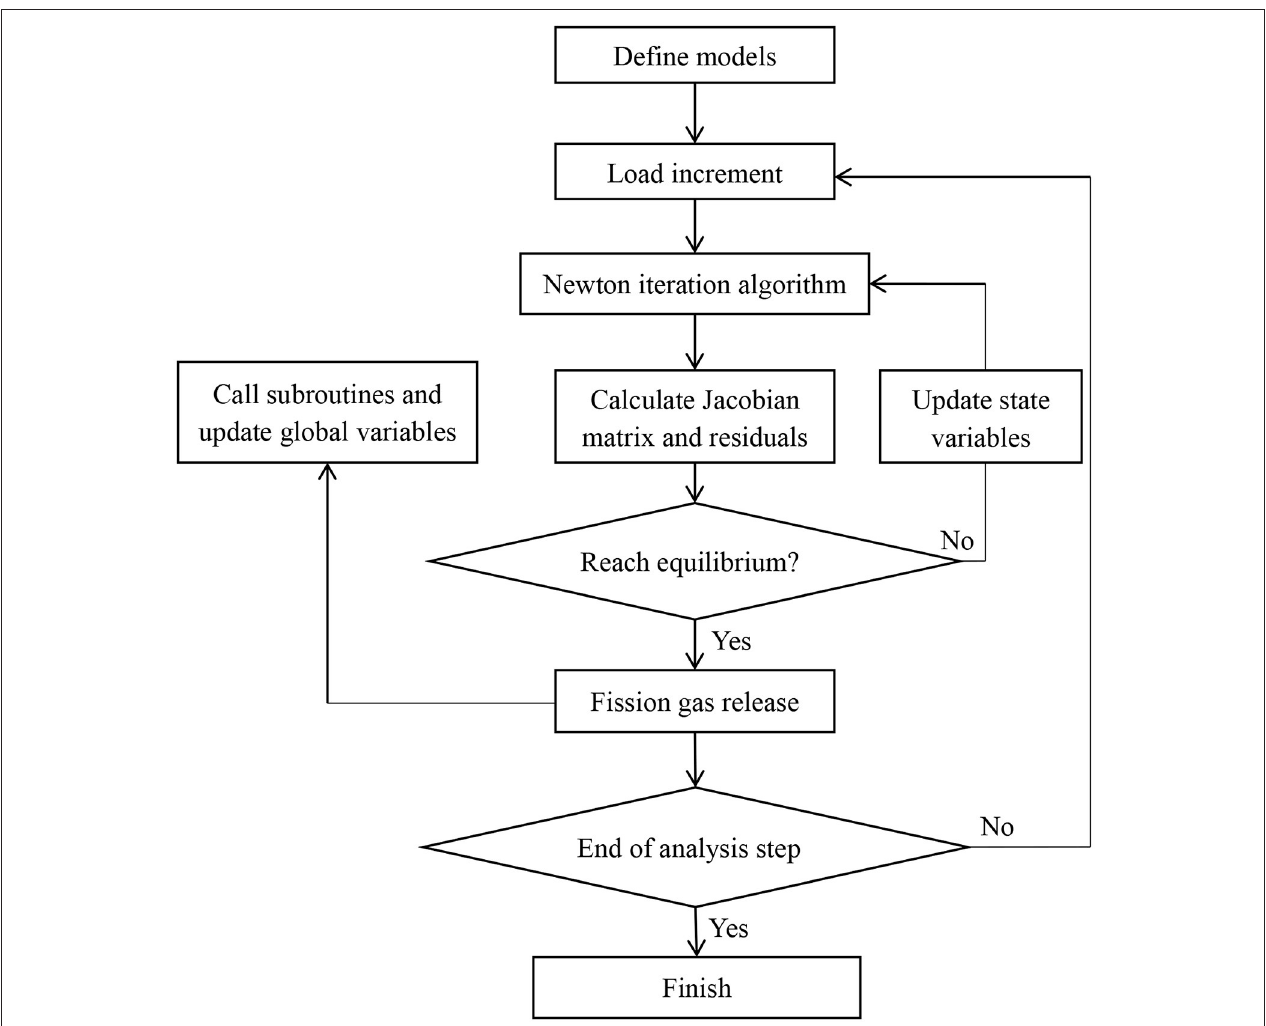
FIGURE 1 | Flowchart of